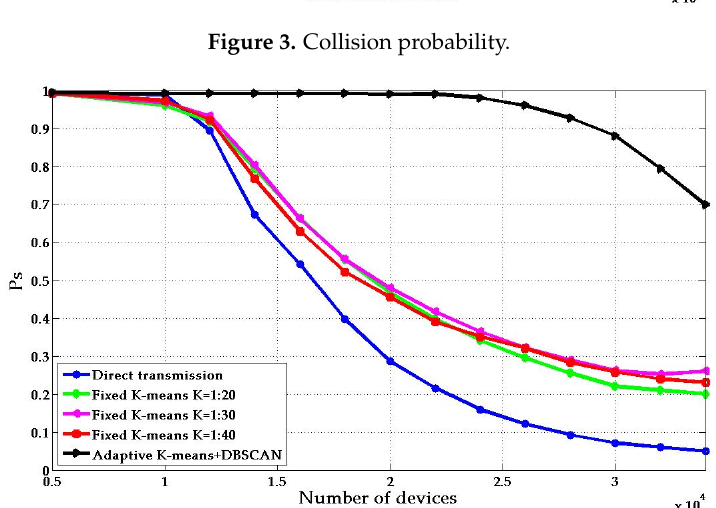
Figure 4. Access success probability.